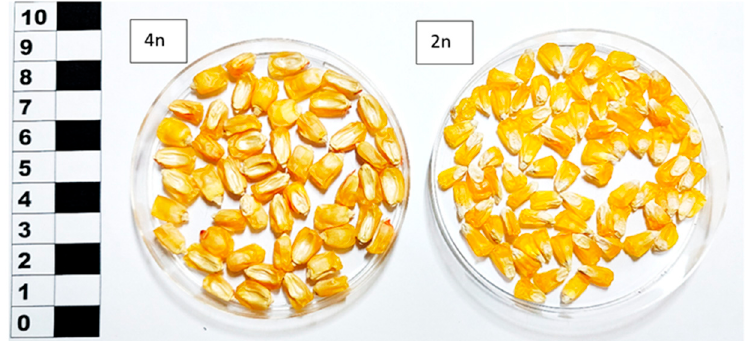
Figure 1. The grain size of tetraploid sugar maize variety Baksanskaya sakharnaya (4 n ) compared with diploid sugar maize variety Alina (2 n ).